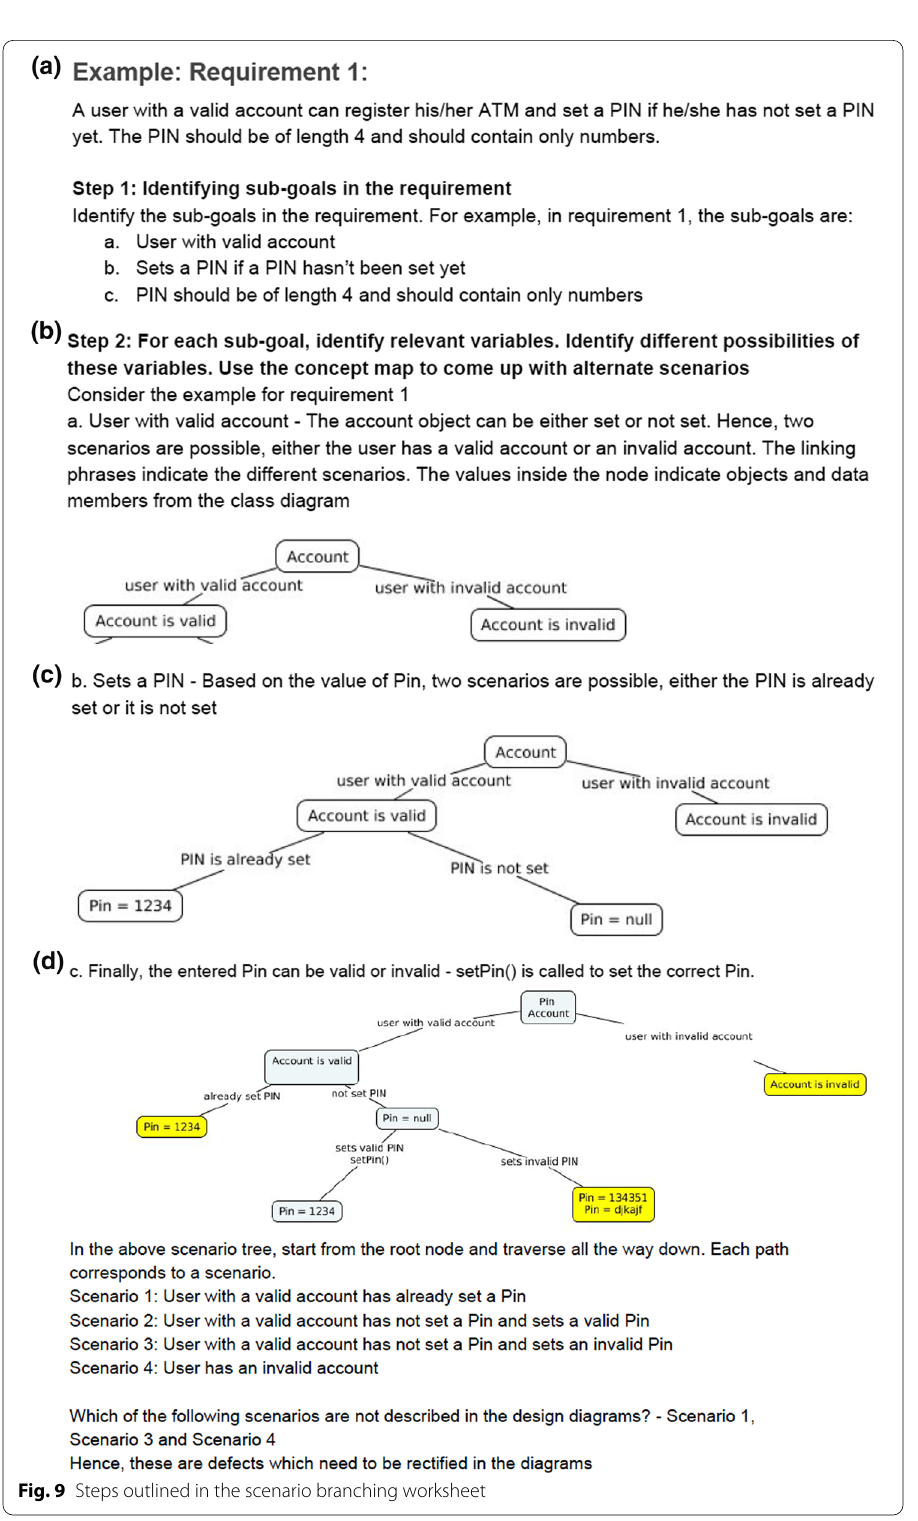
Fig. 9 Steps outlined in the scenario branching